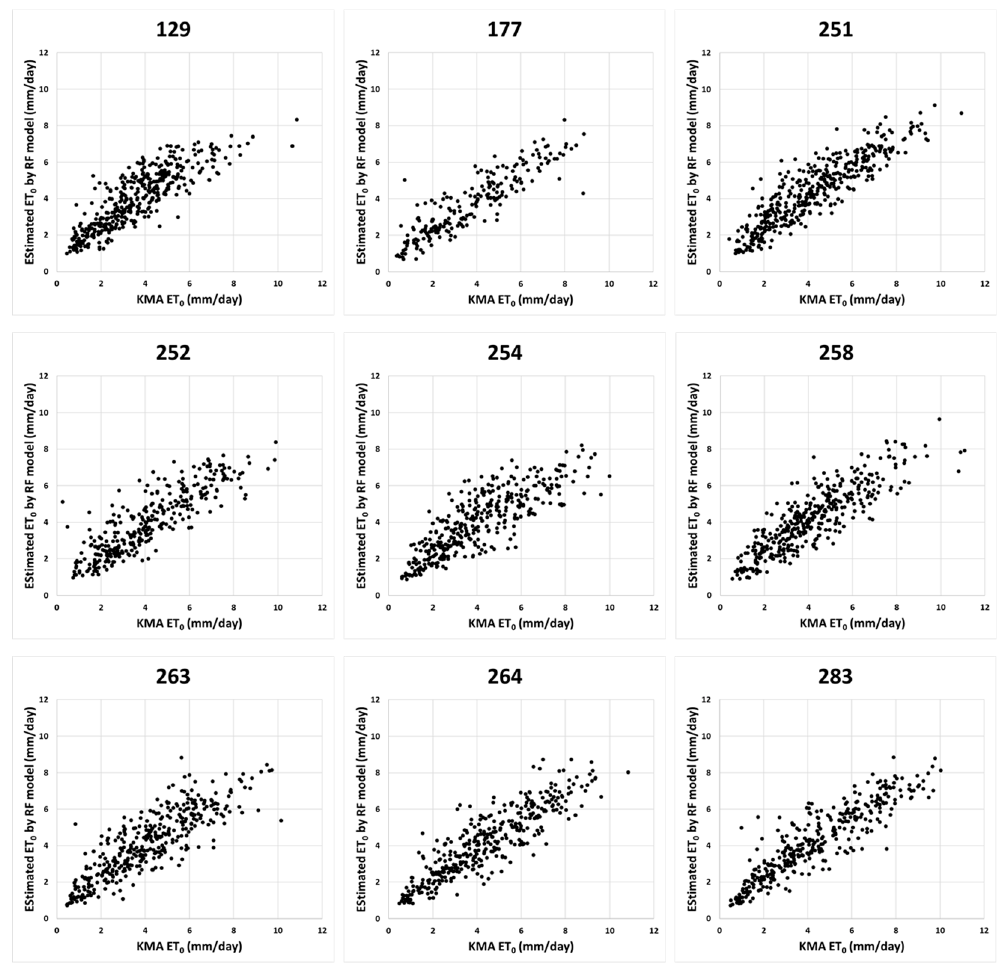
Figure 8. Scatterplots for the observed vs. estimated daily ET 0 in the blind test of the ML model for the nine stations in the croplands of South Korea, 2013–2019. Table 5. Accuracy statistics of the ML-based ET 0 model in the croplands in South Korea, according to